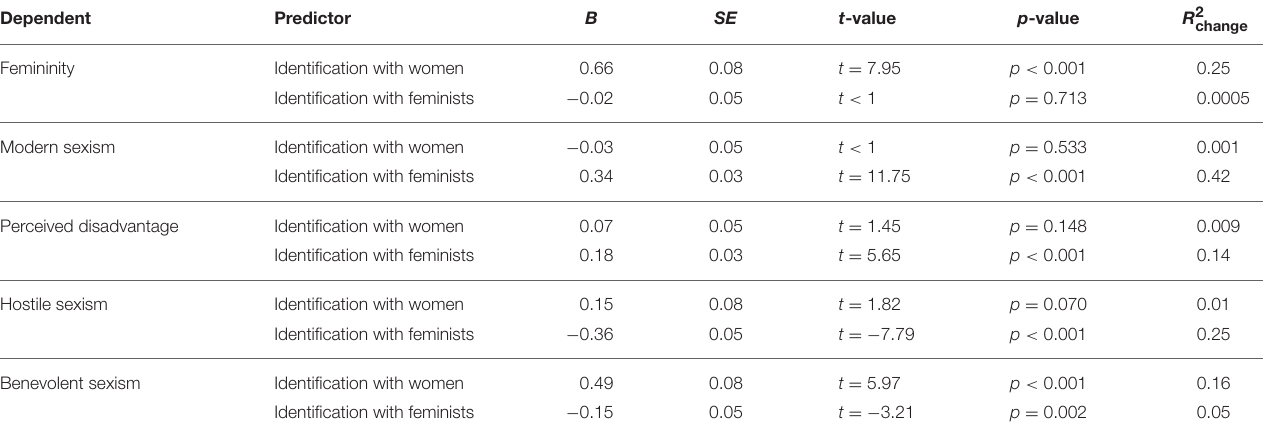
TABLE 5 | Attitudes predicted by identification with women, and identification with feminists in Study 3. Dependent